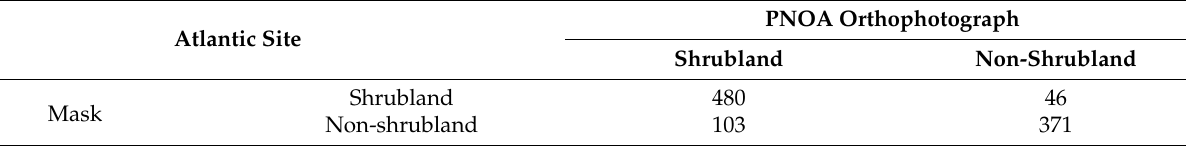
Figure 4. Relationship between field-measured shrub variables and the corresponding LiDAR metrics at plot level for the Atlantic ( A ) and Mediterranean ( B ) sites in post-fire scenarios. The dotted line represents the 1:1 line. Table 1. Confusion matrix and accuracy metrics (ACC —overall accuracy; κ— Kappa index; CE — commission error; OE — omission error) of the pre-fire land cover mask (shrubland and non-shrubland) in the Atlantic and Mediterranean sites.